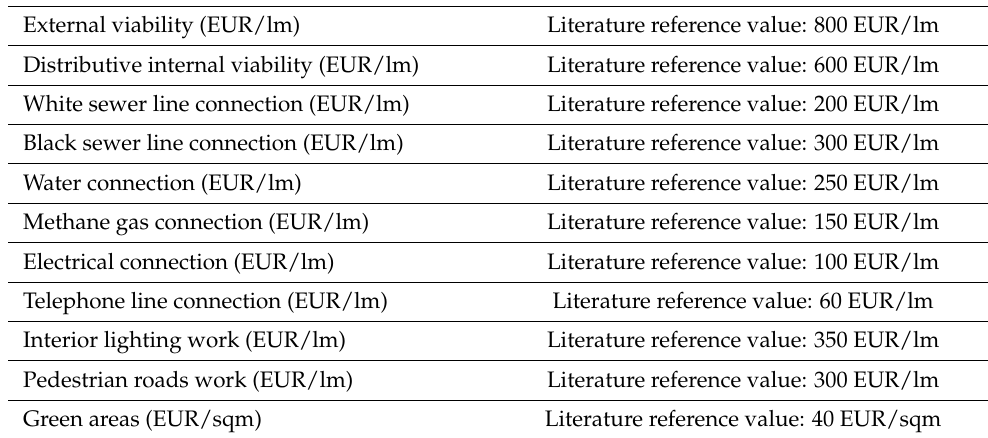
Table A2. Infrastructure costs. In this section, it is required to insert a construction value in EUR/lm or EUR/sqm for each indicated category, according to own experience in hospital construction.